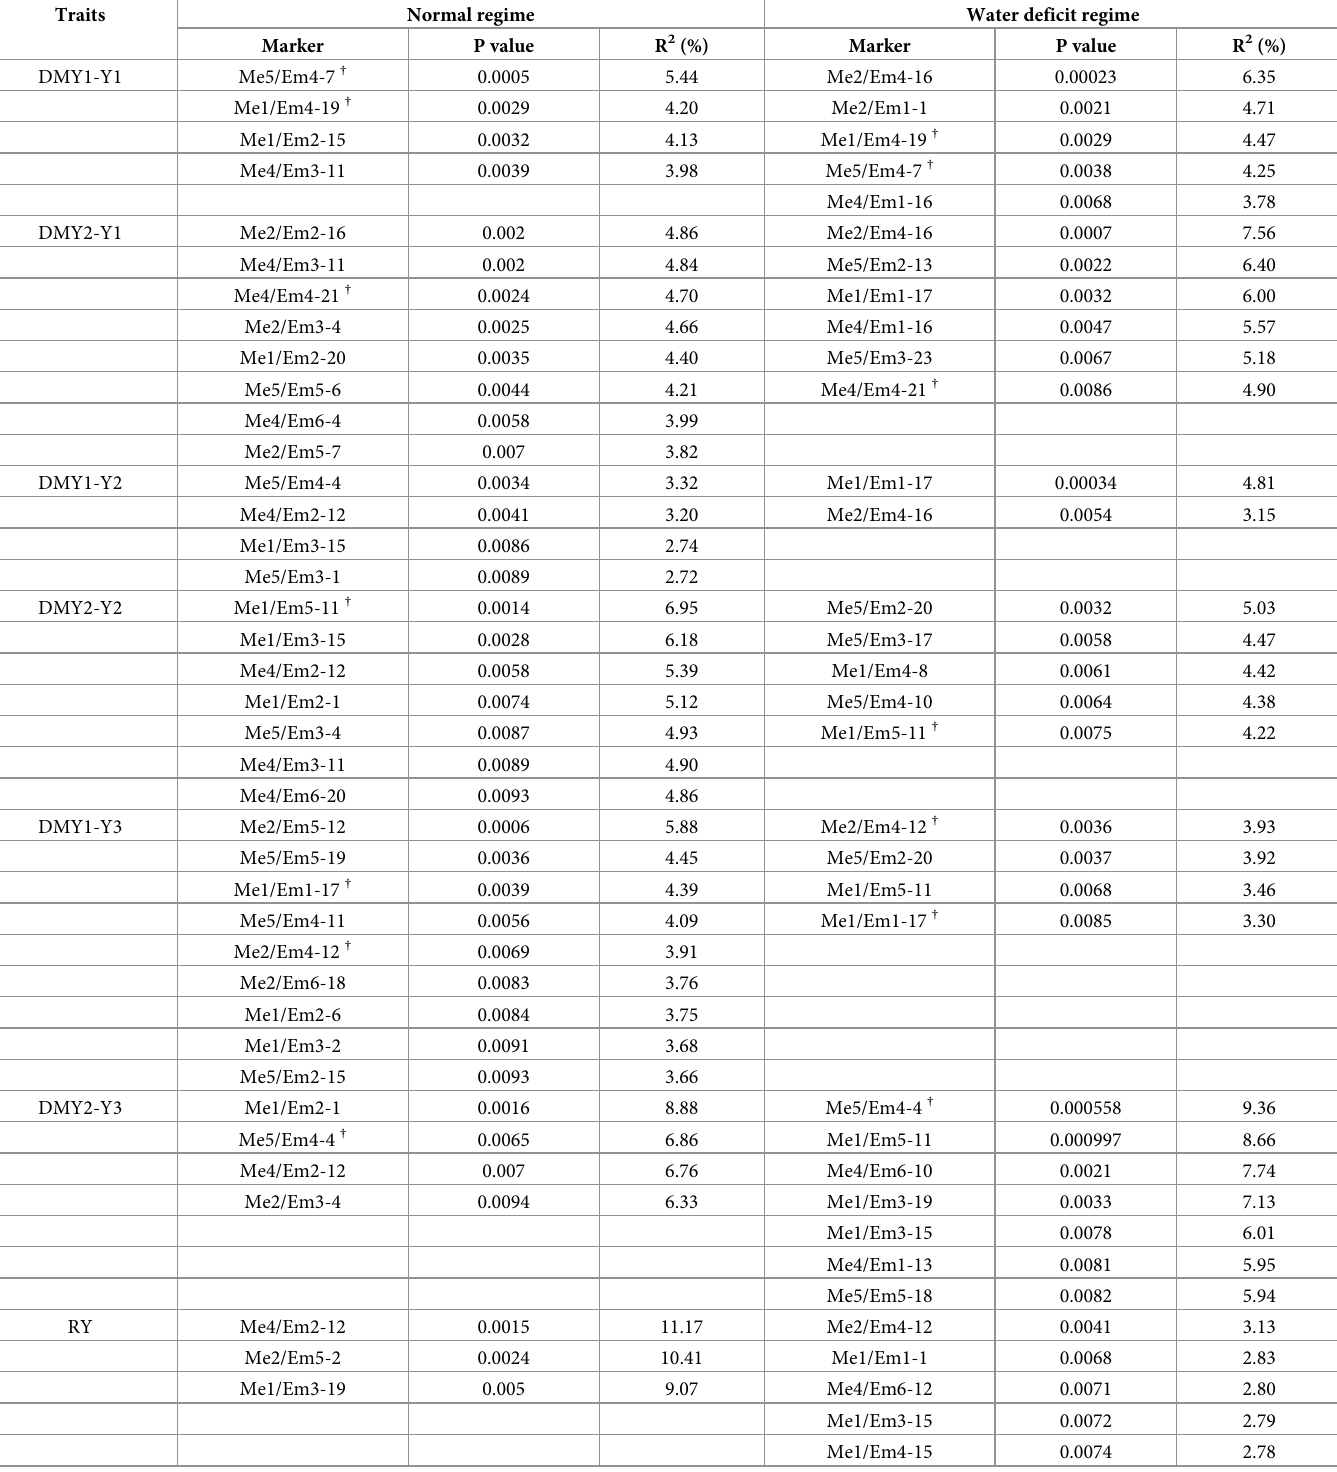
Table 3. Association of SRAP markers with dry matter yield, persistence, summer dormancy, and recovery traits of smooth bromegrass under normal and water deficit regimes based on mixed linear model (MLM).